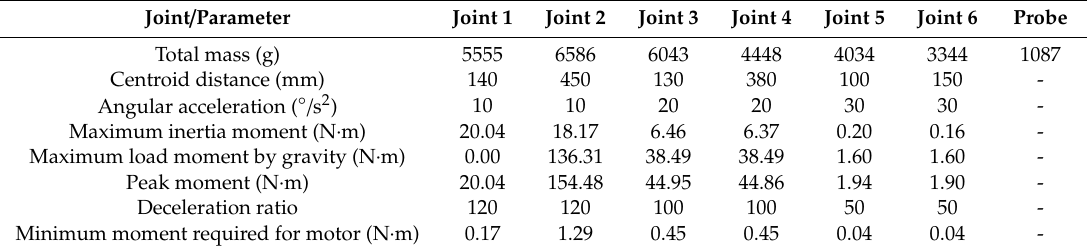
Table 1. Results of motor torsion estimation [31].